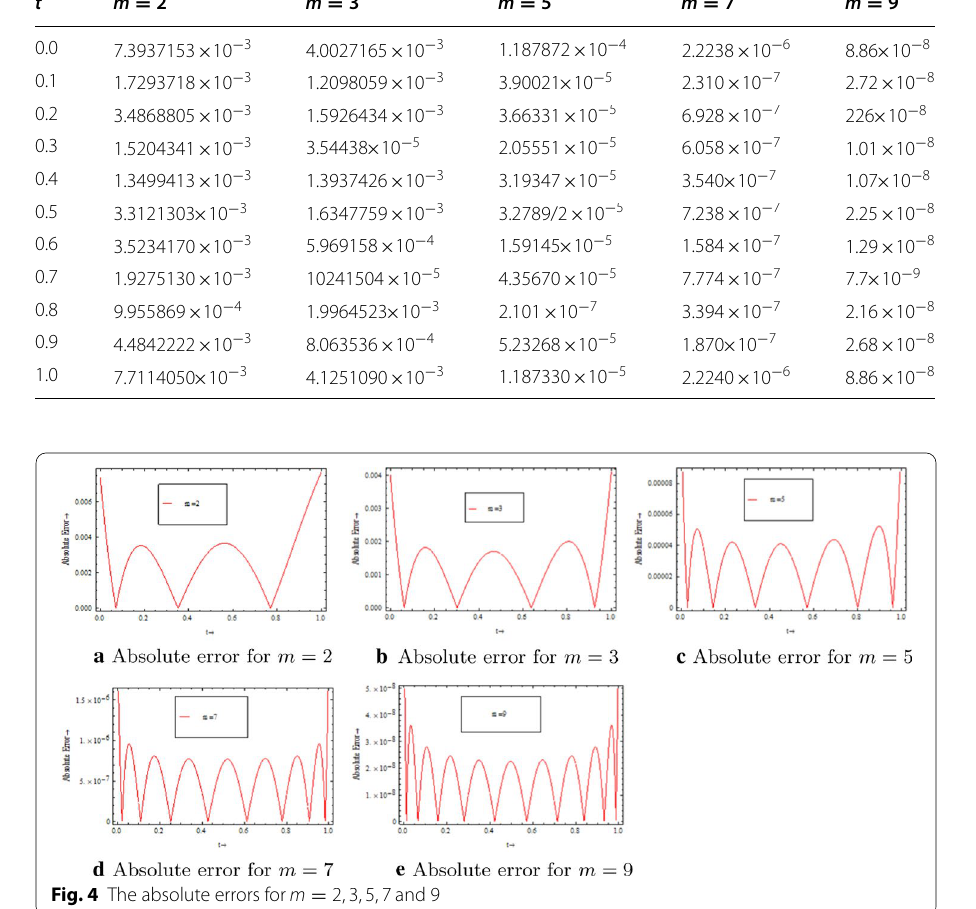
Table 4 Absolute errors for Example 2 given by � y e − y a � are t